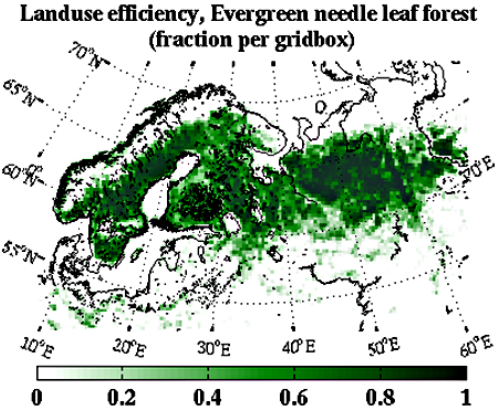
Figure 1. The northern European boreal forest domain, repre- sented here by evergreen needleleaf forest as fraction of grid cell, remapped from the modified IGBP MODIS data to 27 × 27km res-